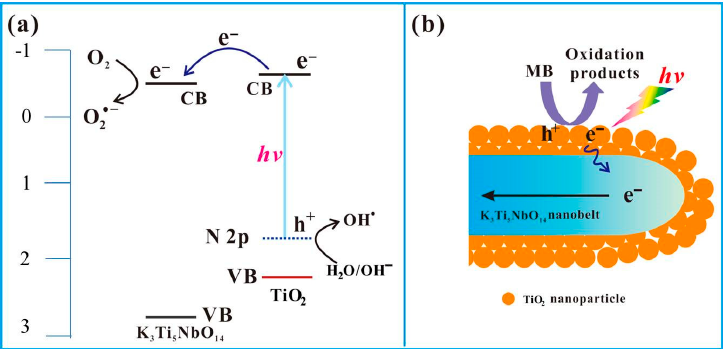
Figure 10. A possible photocatalytic mechanism of the NTNT for the photodegradation of the organic pollutants.